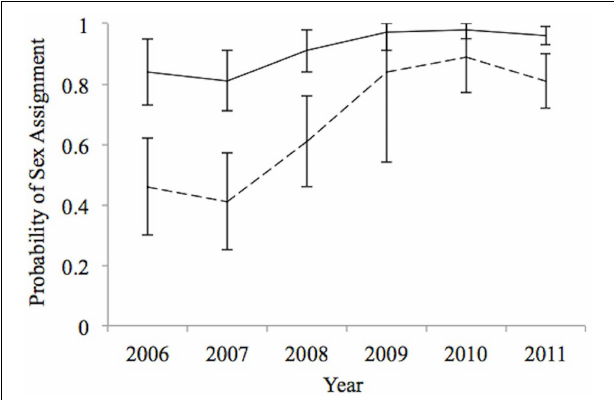
FIGURE 2 | Estimated probability of sex assignment from best-supported model for 2006–2011, which represents our ability ( ± 1 SE) to unambiguously assigning sex (Male; –, Female; – –) to an unsexed shark on a given sampling occasion